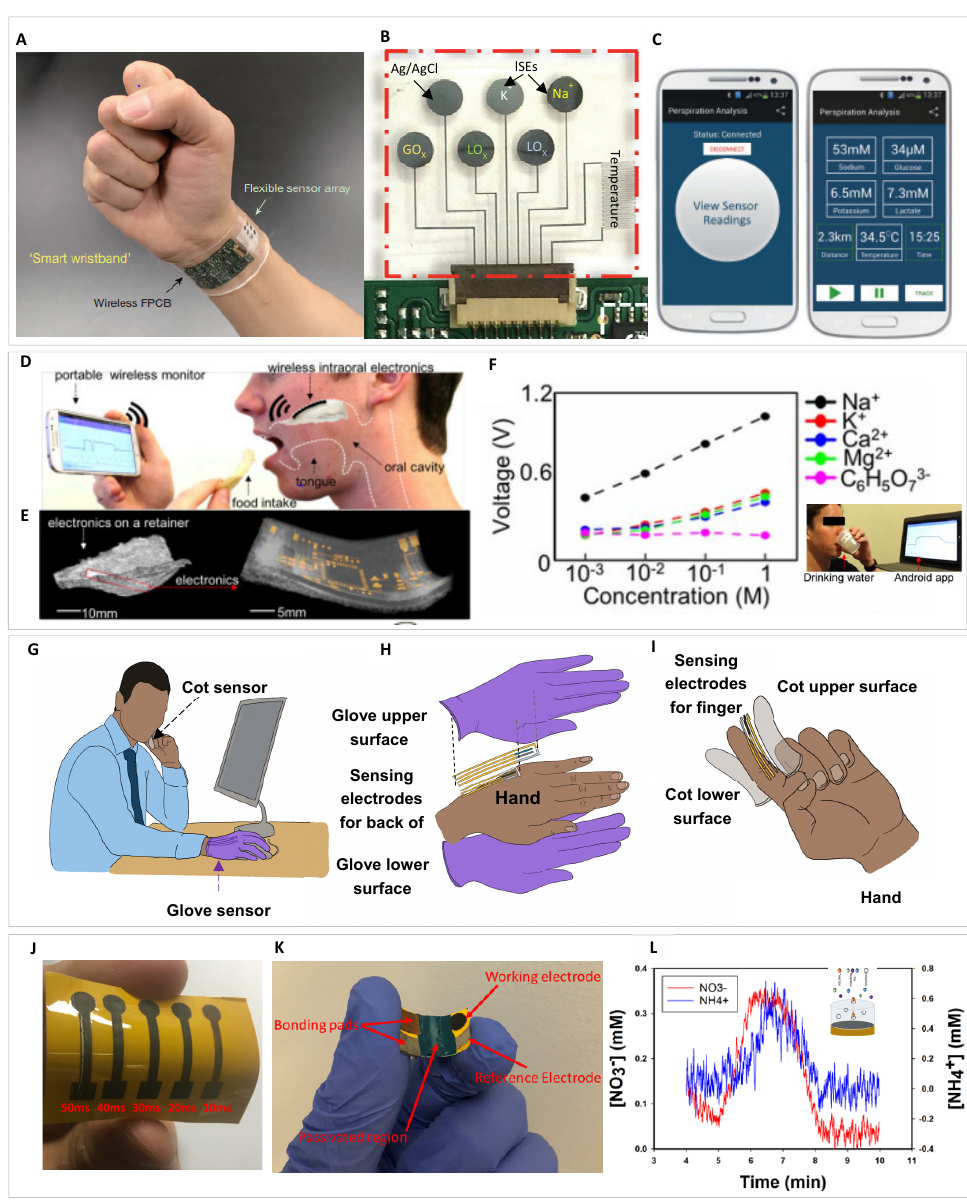
Figure 3. Wearable sweat sensor and ion sensing results via wireless Bluetooth transmission on a mobile device. ( A ) Shows the wireless flexible printed circuit board (FPCB) and integrated multi- plexed sweat sensor array and of a wearable flexible integrated sensing array (FISA) on a subject’s wrist. ( B ) Multiplexed sensor array for sweat analysis. The red dashed box shows the sensor